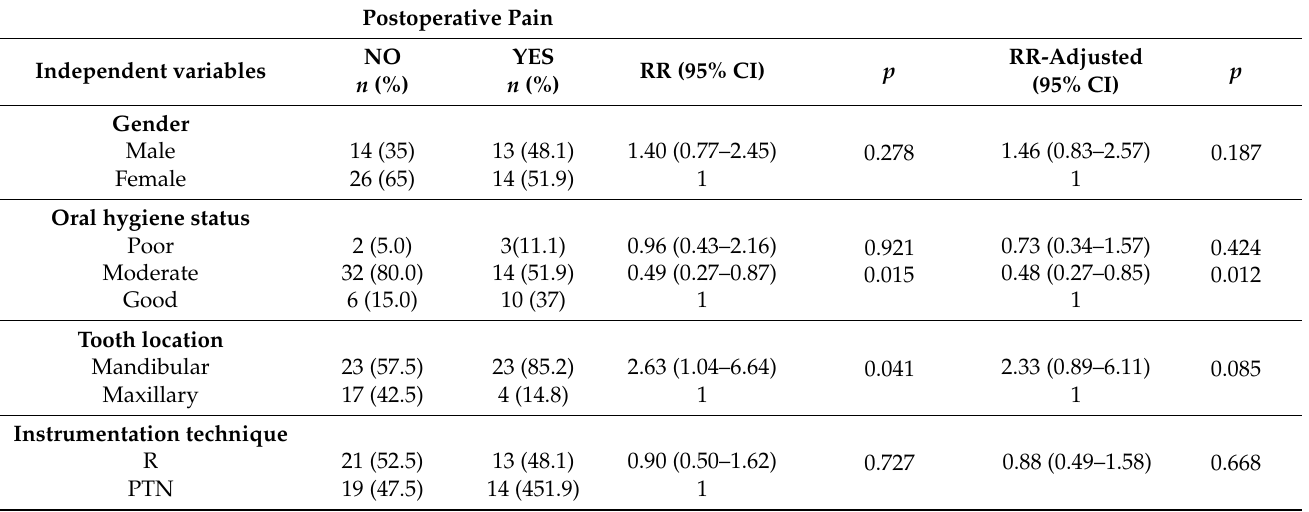
Table 4. Non-adjusted and adjusted Poisson regression analyses for postoperative pain 12 h after root canal instrumentation according to the patient’s gender, oral hygiene status, tooth location and instrumentation